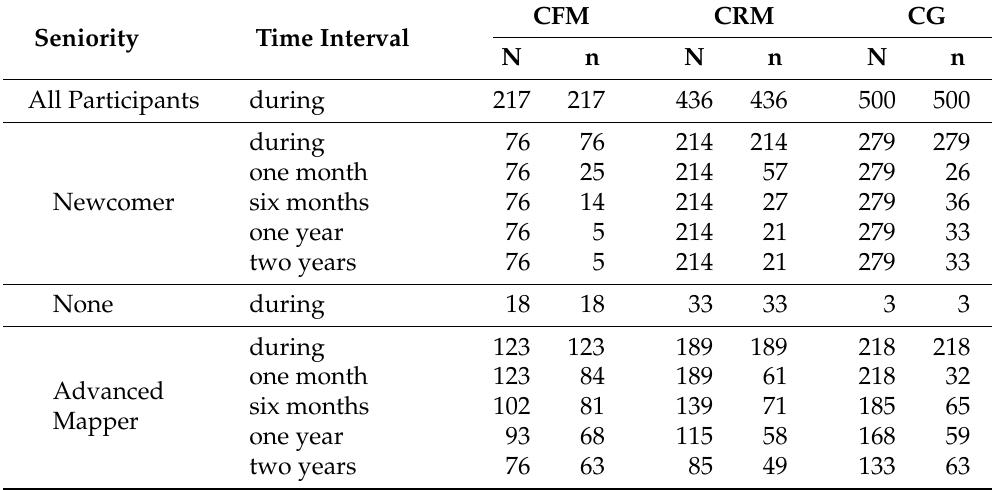
Table 3. Summary of number of analysed users per category for the different statistical tests. N is the number of potential attendees qualifying to be included for the respective time frame and n the number of actual contributors to the respective time frame. All newcomers that participated at an event are potential contributors thereafter, but since not all users stayed active, n is decreasing with time. Advanced mappers were analysed for the maximum time interval of their OSM presence before the event, meaning that an advanced mapper who joined one month before the event was only analysed for the same time frame after the event. Therefore, N is decreasing with time for this group. In addition, advanced users may become inactive for some time intervals as well, leading to a fluctuation of n . Users had to be ignored (None) if they were not registered for a full month before their respective event but also did not classify as